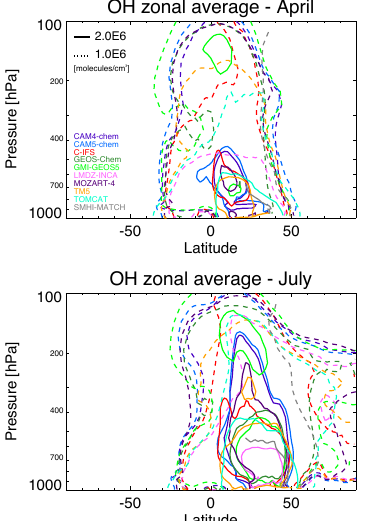
Figure 6. Location of the 1.0 and 2.0 × 10 6 moleculescm − 3 con- tours of OH for the zonal averages of each model in April and July.